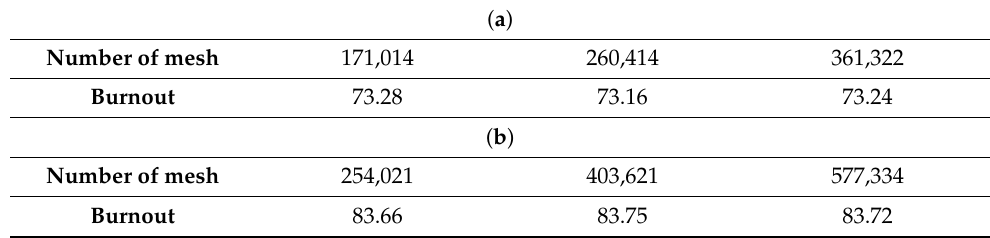
Table 1. The coal burnout of different numbers of meshes: ( a ) Base case; ( b ) targeted